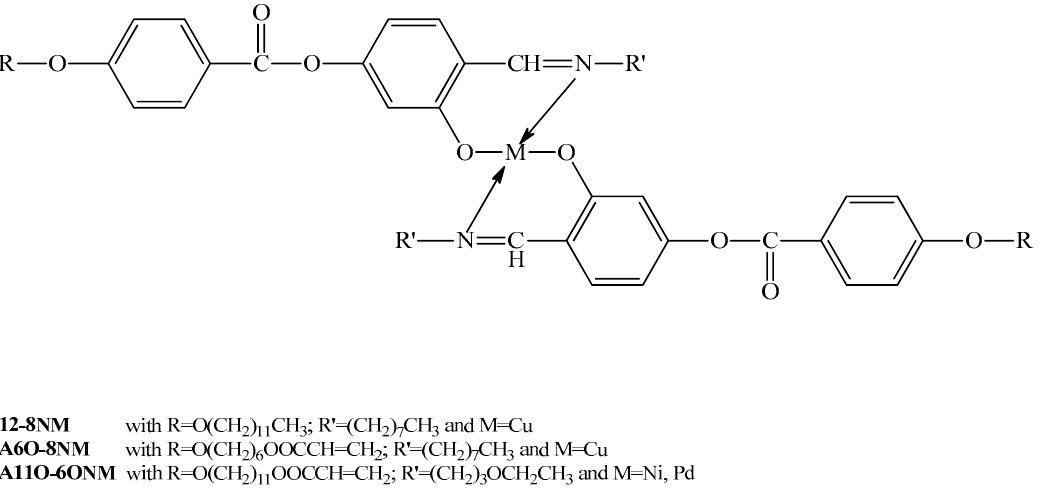
Scheme 1. General formula of metallomesogen (MOM)